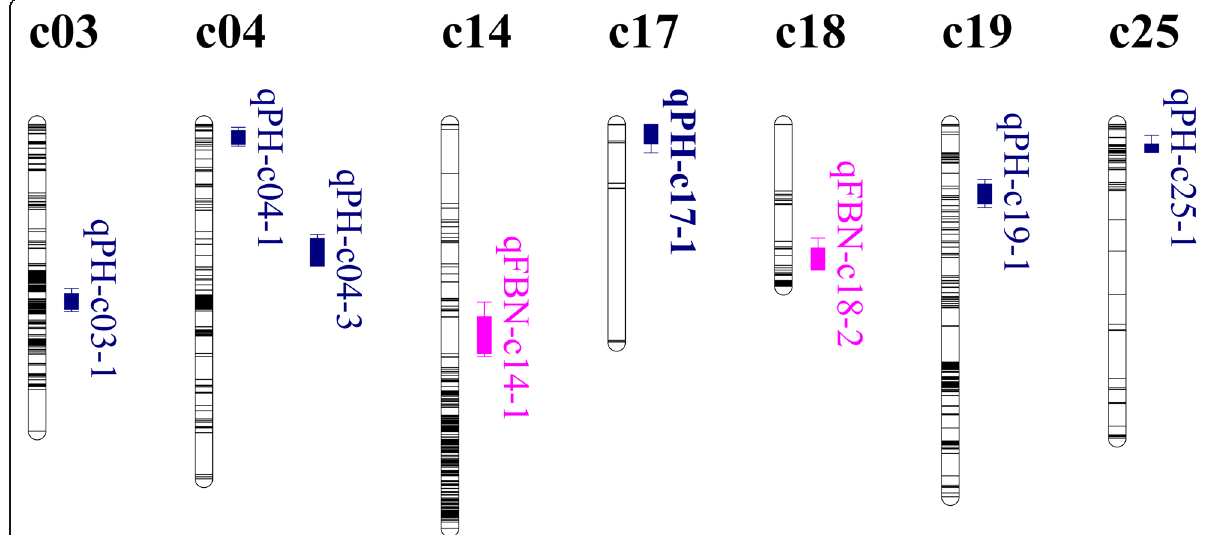
Fig. 1 The stable QTL for PH and FBN were distributed in chromosomes